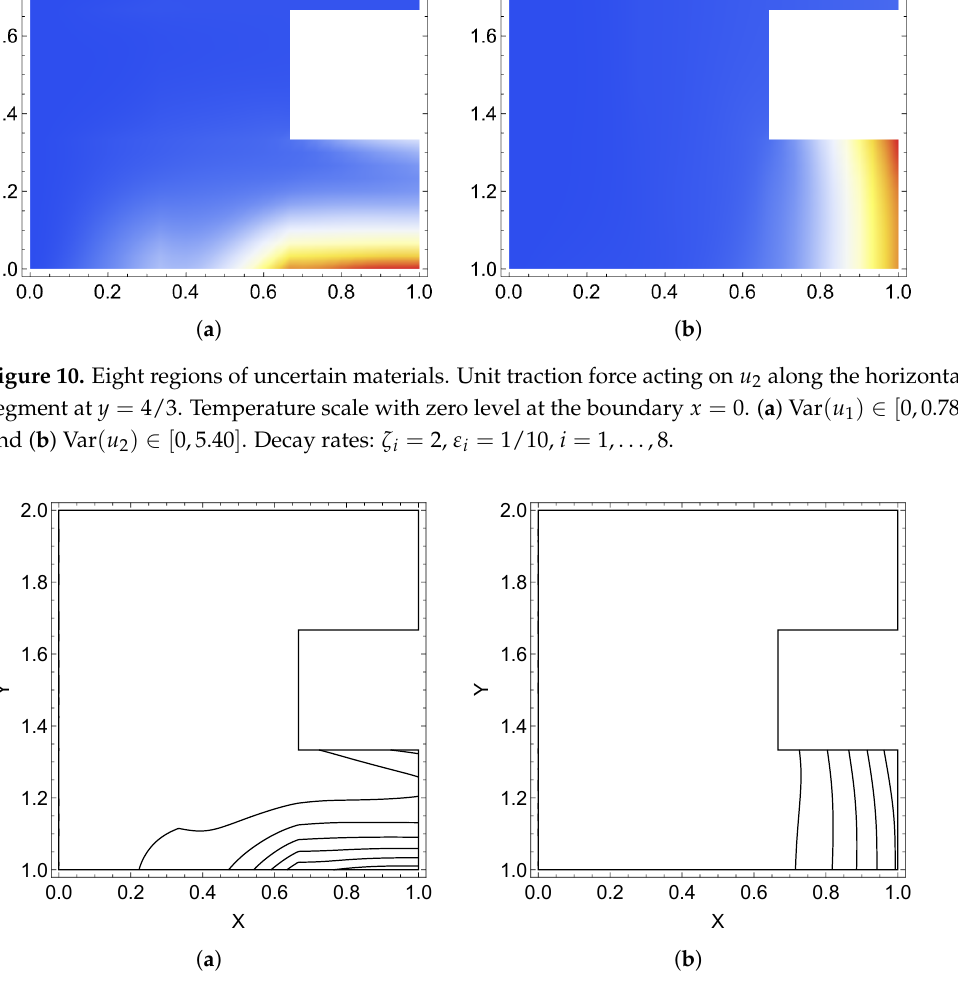
Figure 11. Eight regions of uncertain materials. Contour plots of the variance of the vector field components. The zero level is at x = 0 in both pictures. The plots are not directly comparable, as (cid:107) Var ( u ) (cid:107) = 0.1 < (cid:107) Var ( u ) (cid:107) = 1.0. ( a ) Var ( u ) and ( b ) Var ( u ) . 2 2 2 2 1 1 The contour plots are useful in verifying the line projection plots of the variance in Figure 12. As the underlying formulation is continuous, there are no jumps in the variance, although the effects of the multiple regions can immediately be identified from the plots. This kind of information is valuable when the sensitivity of the design with respect to individual parts is estimated a